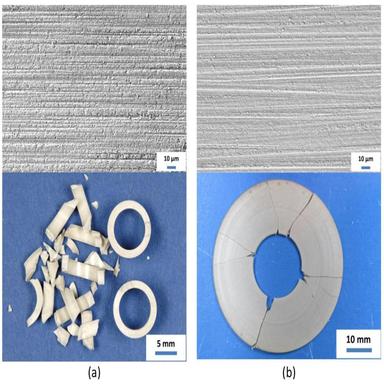
Surface morphology and fracture pattern of (a) helical springs and (b) disk springs tested in cyclic fatigue at 1000 °C.